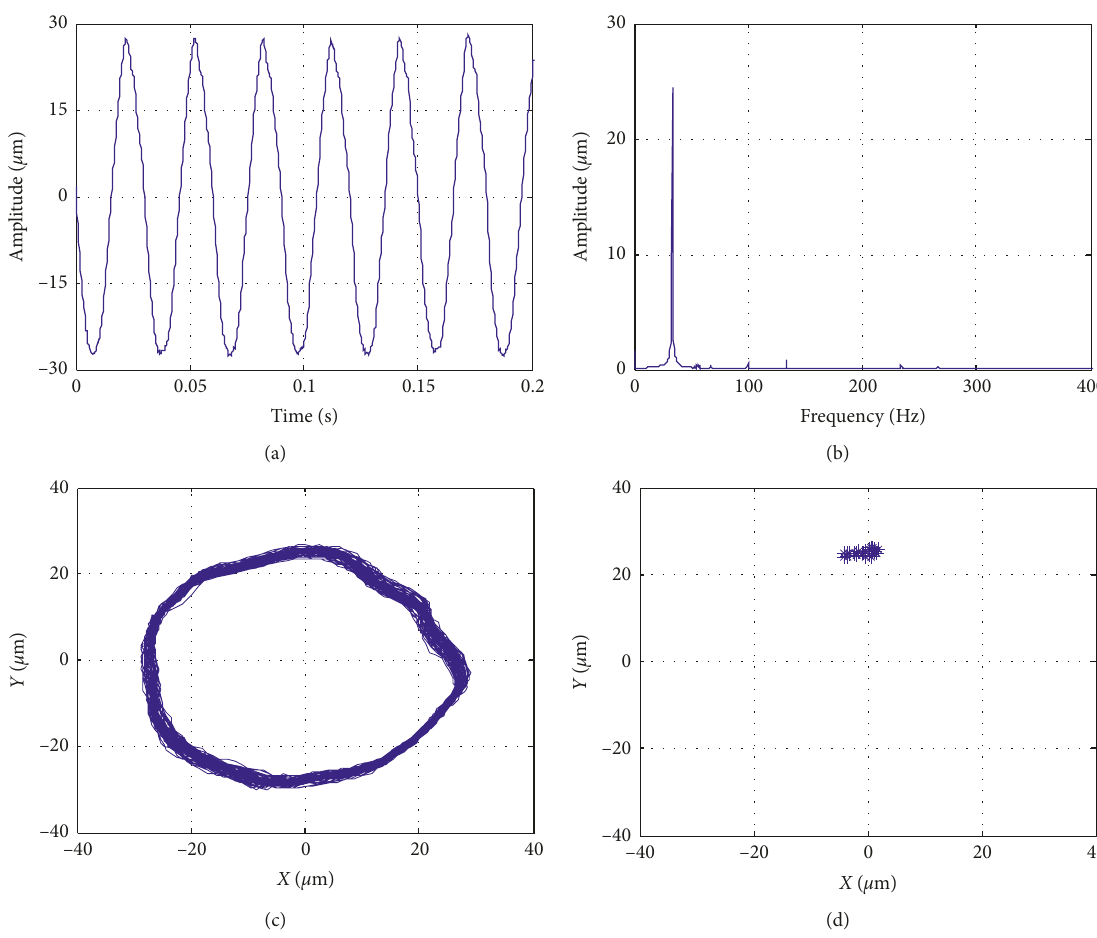
Figure 7: Normal state at 2000r/min. (a) Time-domain waveform. (b) Spectrum graph. (c) Axis orbit. (d) Poincare